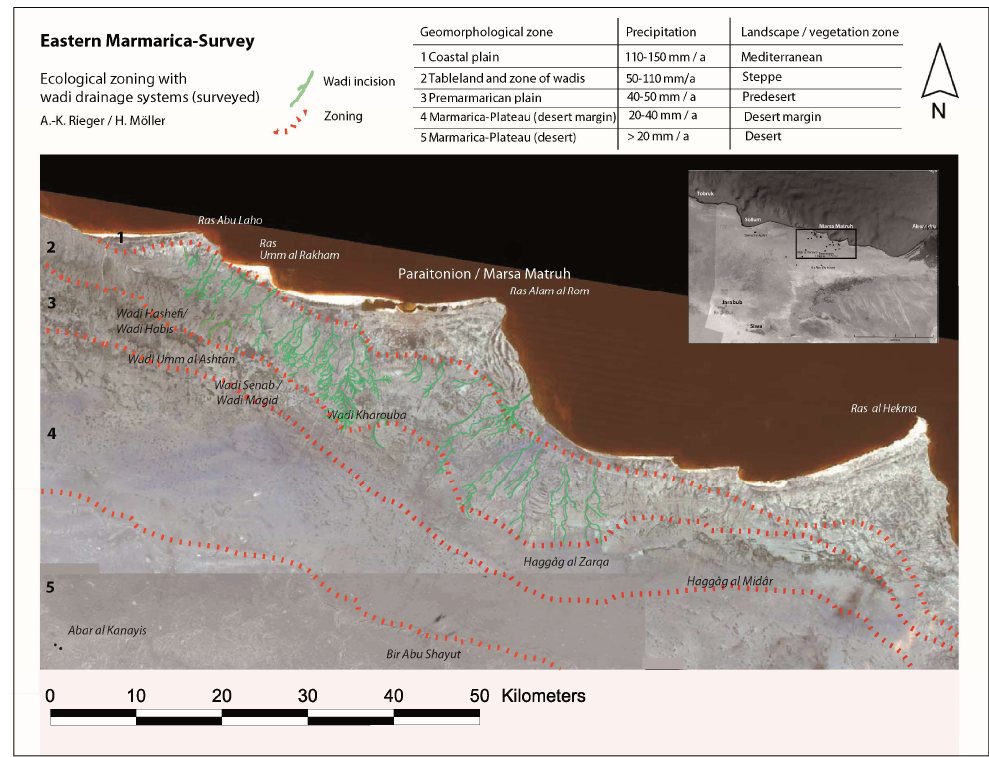
Figure 11. Cistern density in the area between Sidi Barrani/Ainesisphyra and Marsa Matruh/Paraitonion in recent times in correlation to mean rainfall, relief, and coastal distance. A high number of the cisterns on the tableland date back to Roman times, whereas the surveyed cistern sites on the Marmarica Plateau show evidence of older periods. Graph: T. Vetter.